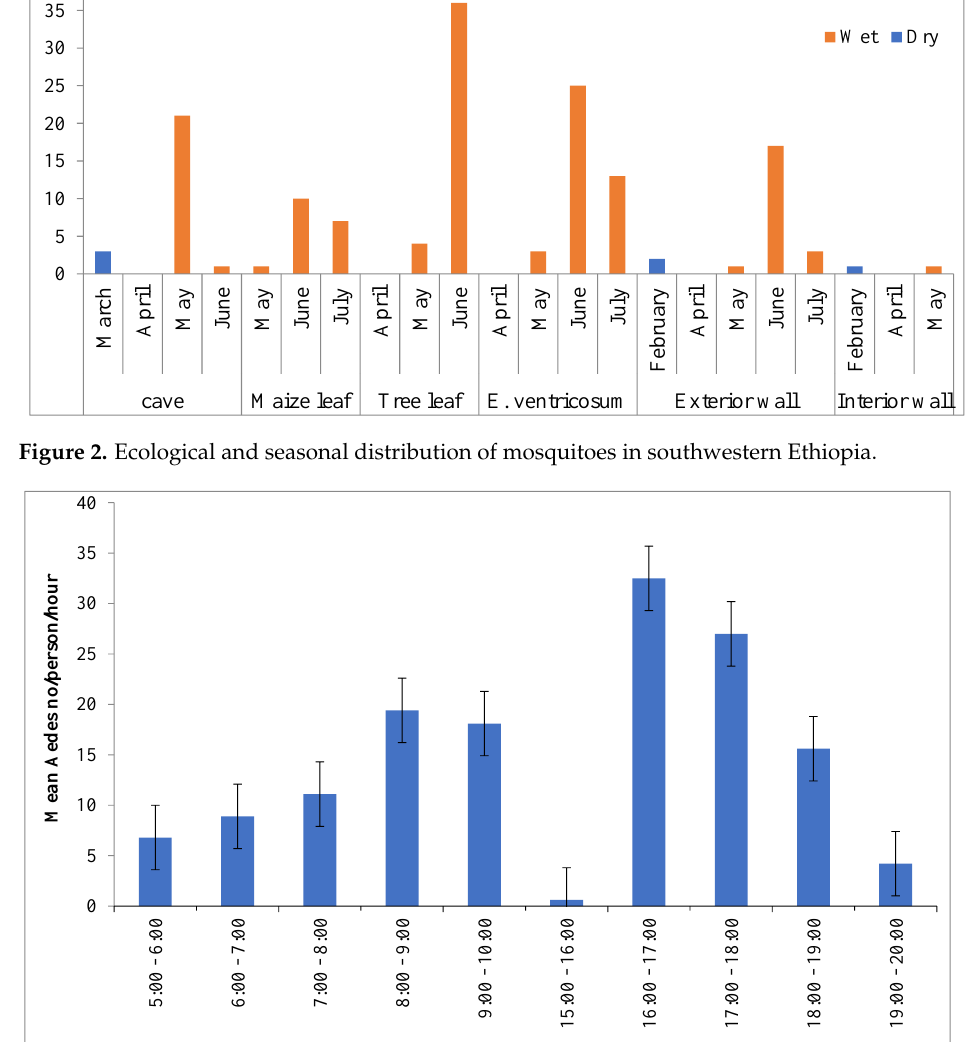
Parasitologia 2023 , 3 , FOR PEER REVIEW